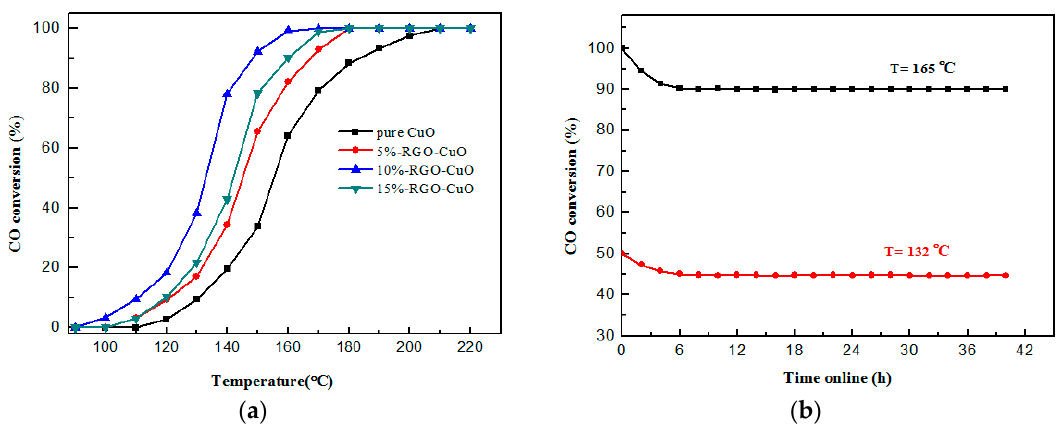
Figure 6. ( a ) Catalytic activity for CO oxidation of the pure CuO and RGO–CuO catalyst with different RGO contents; ( b ) CO conversion over the 10% ‐ RGO–CuO catalyst at 132 °C and 165 °C as a function of reaction time.